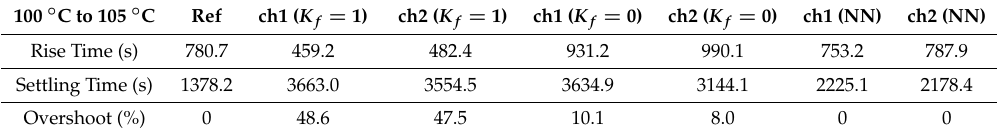
Figure 8. Simulation results. ( a ) Full time response for the control system. ( b ) Results of positive direction control for the temperature from 100 ◦ C to 105 ◦ C and negative direction control for the temperature from 105 ◦ C to 100 ◦ C. Table 1. Comparison of simulation results for time response characteristics (100 ◦ C to 105 ◦